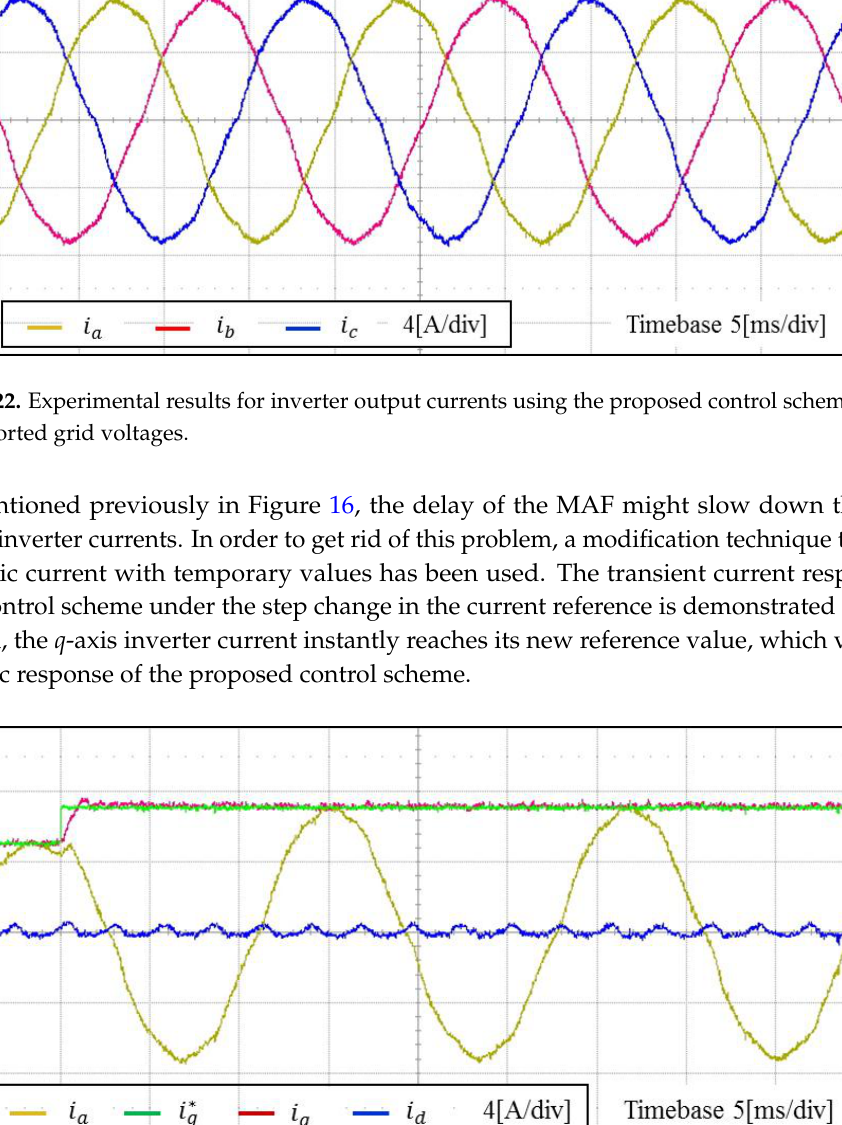
Figure 24. FFT result of a -phase current using the proposed control scheme under the distorted grid voltages. As a result, the proposed control scheme has a good disturbance rejection capability in steady state as well as fast dynamic response. 6. Conclusions In this paper, an improved current control strategy for a grid-connected inverter even in the presence of distorted grid conditions has been proposed for DG systems. The proposed control scheme is designed to overcome the limitation of the conventional PI type control schemes under adverse operation conditions of grid. Two significant enhancements in the proposed control scheme are the implementation of a robust PLL algorithm and the additional harmonic suppression scheme. This is achieved by introducing the model decomposition method and MAF, by which the inverter model can be decomposed into the fundamental and harmonic components. Based on the derived models, the fundamental and harmonic currents are independently controlled by a decoupling PI controller and a predictive basis controller, respectively. The principle and mathematical description